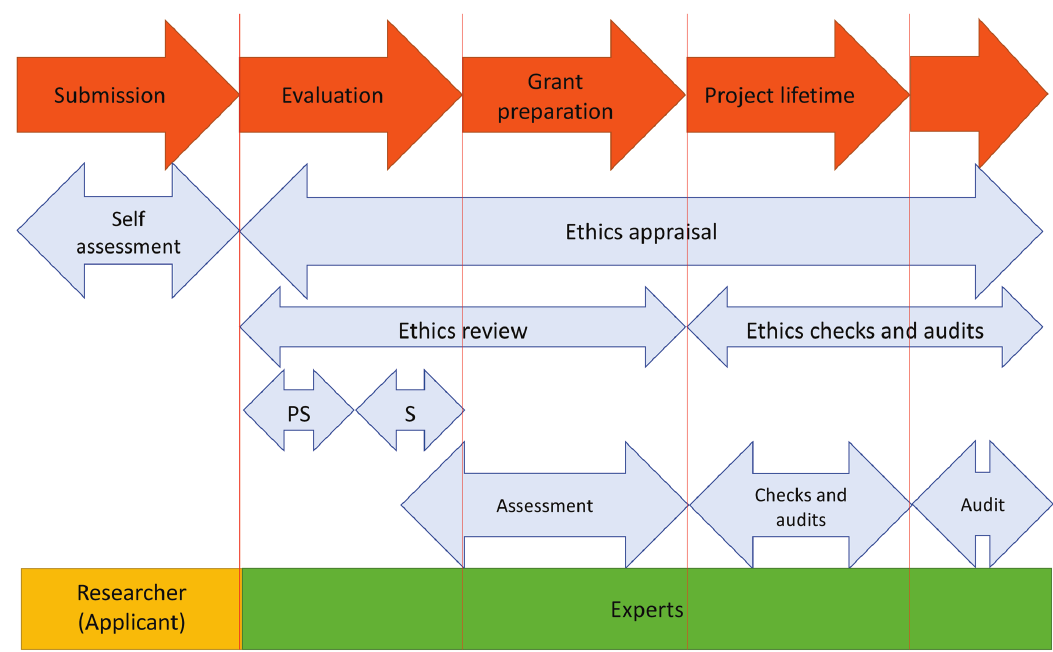
Figure 1. Ethics appraisal procedure in Horizon 2020. PS – pre-screening, S – screening. Pre-screening in European Research Council (ERC) evaluation process is performed by internal ERC